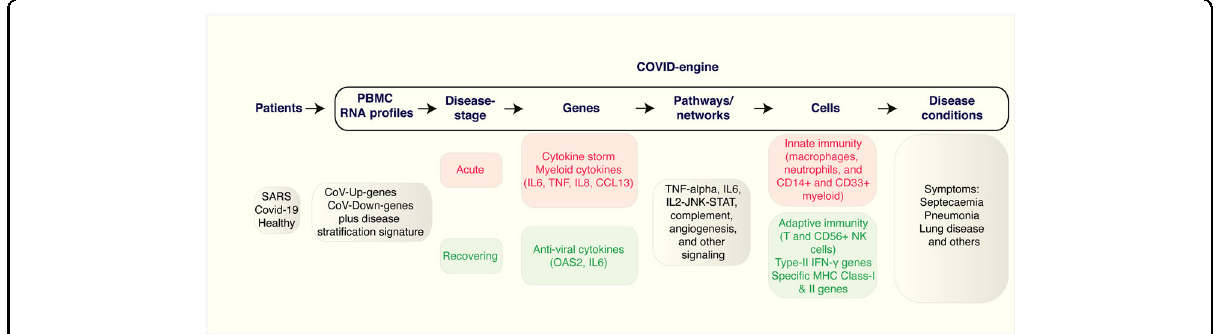
Fig. 8 COVID-engine work fl ow. Schematic summarizing the gene signature and their relevance at systems level to disease progression stages, and disease conditions for personalized COVID-19